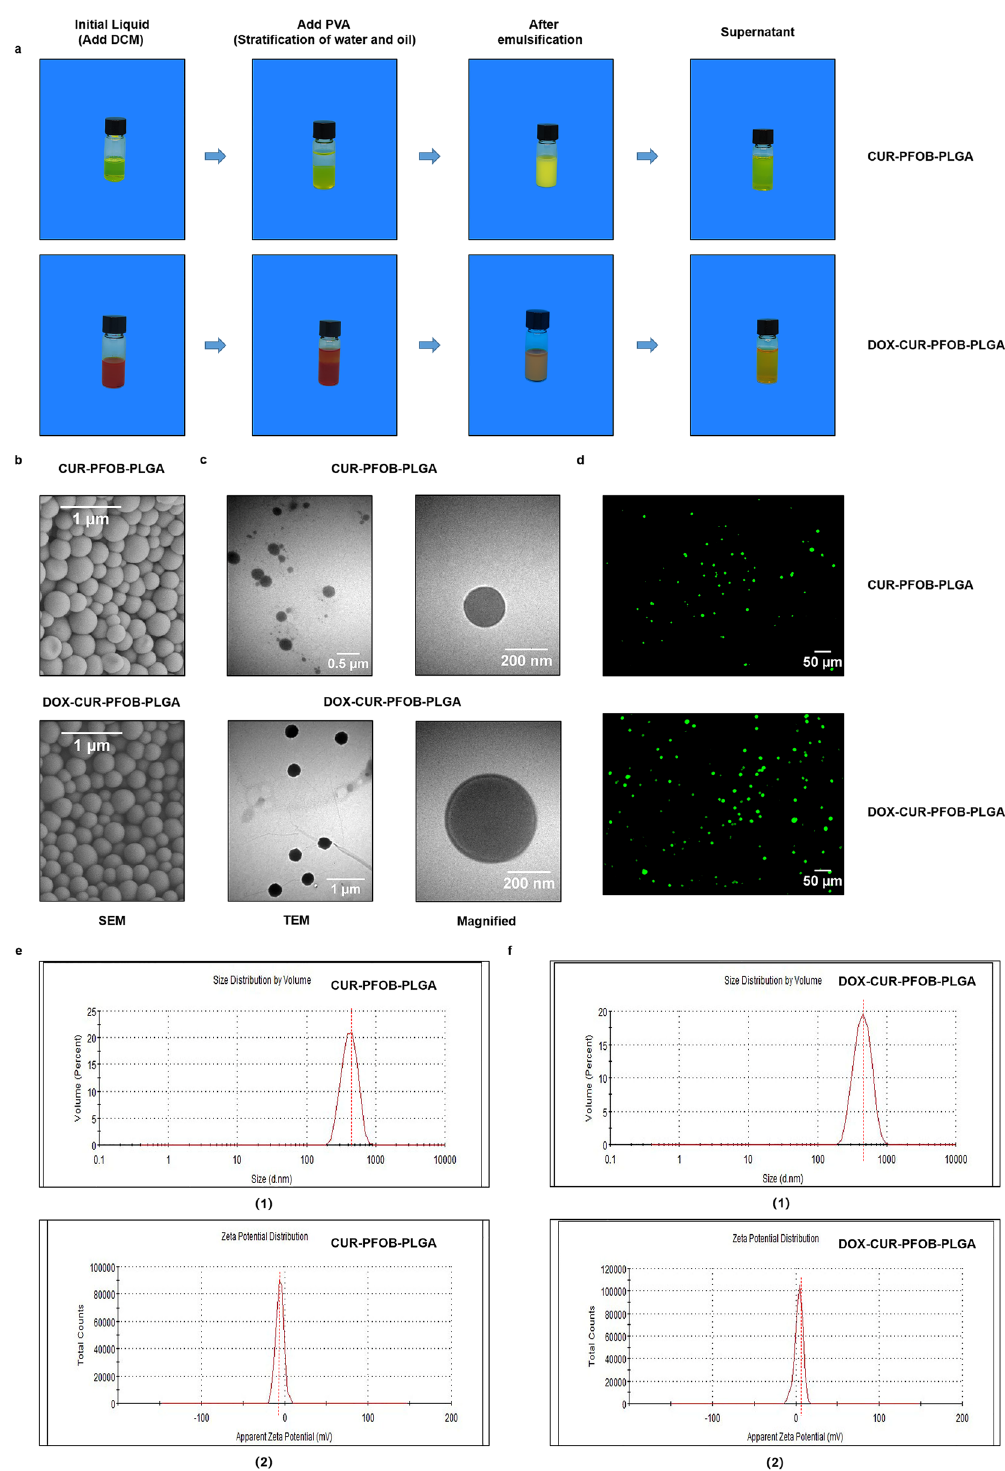
Figure 2. Preparation and morphological characterization of nanoparticles (NPs). ( a ) Digital camera photos of the preparation process of CUR–PFOB–PLGA and DOX–CUR–PFOB–PLGA NPs including dichloromethane (DCM) dissolution of the drugs, water–oil phase separation after polyvinyl alcohol (PVA) addition, emulsification, and the supernatant collected by centrifugation. ( b ) SEM images of CUR–PFOB–PLGA and DOX–CUR–PFOB–PLGA NPs; ( c ) TEM images of CUR–PFOB–PLGA and DOX–CUR–PFOB–PLGA NPs (The right images were the magnification of NPs.); ( d ) Morphology of NPs under inverted fluorescence microscope (The CUR in NPs showed green fluorescence by excitation.); ( e ) Size distribution (1) and Zeta potential (2) of CUR–PFOB–PLGA NPs by DLS (Mean diameter: 421.80 ± 111.50 nm); ( f ) Size distribution (1) and Zeta potential (2) of DOX–CUR–PFOB–PLGA NPs by DLS (Mean diameter: 409.77 ± 7.56